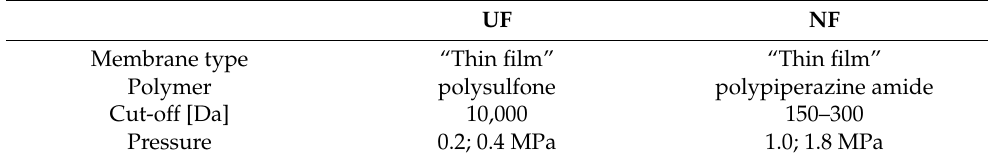
Table 3. Characteristic of ultra- and nanofiltration